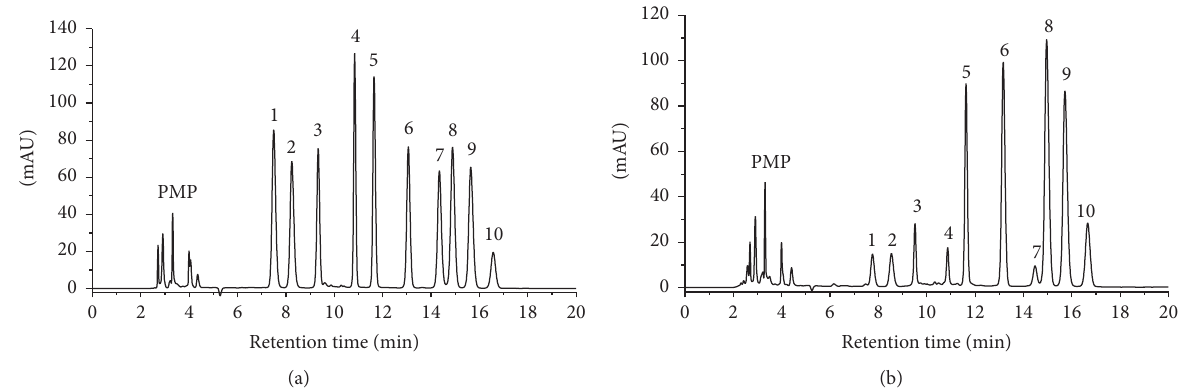
Figure 1: Chromatograms for analysis of (a) the synthetic mixture of ten standard monosaccharides and (b) the component monosaccharides present in Yingshuang green tea TPS using the pre-column PMP derivatization HPLC method. Peaks: 1: mannose; 2: ribose; 3: rhamnose; 4: